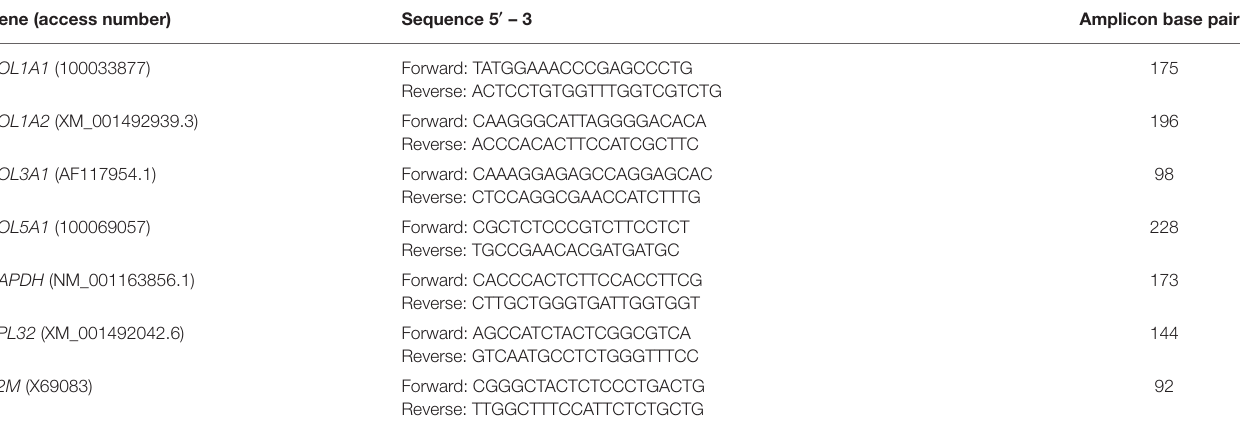
TABLE 1 | Primer sequences used in real time PCR analysis of